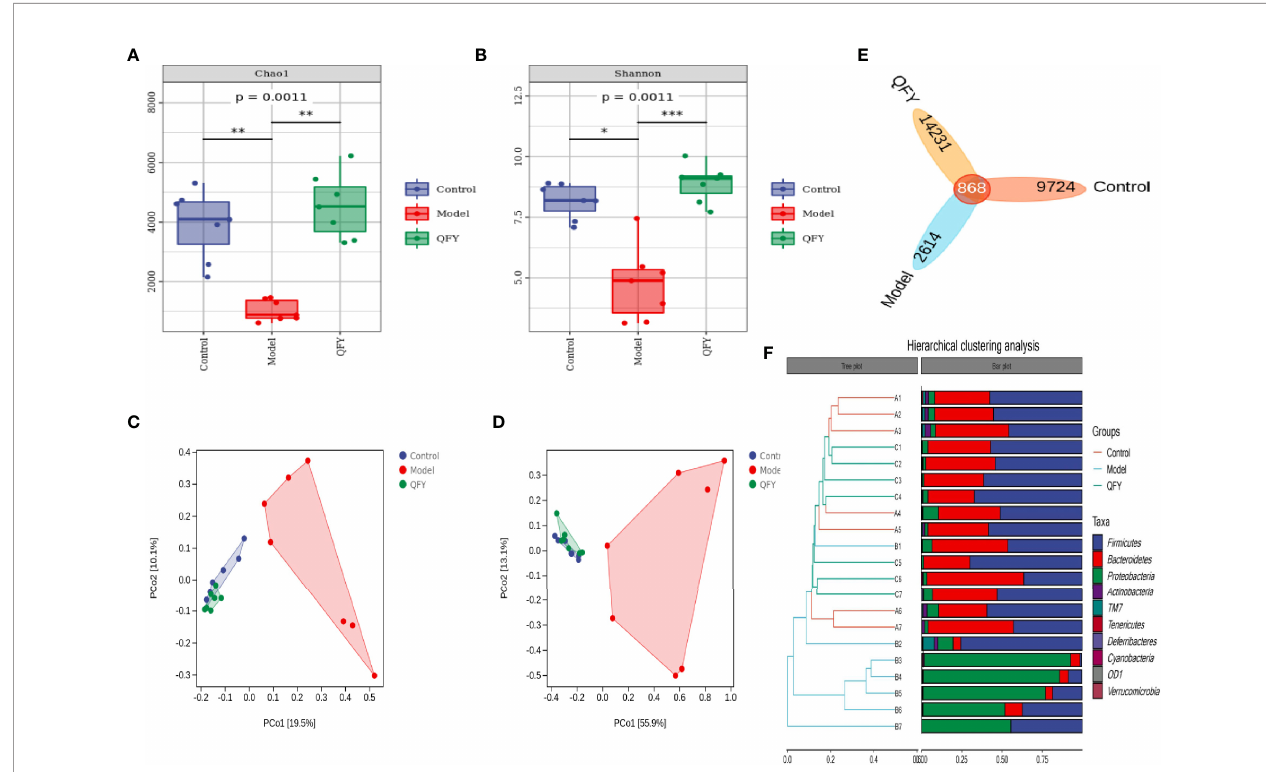
FIGURE 2 | Alpha diversity metrics comparisons among Control, Model, and QFY groups using (A) Chao 1 indices, (B) Shannon indices, and (C, D) weighted and unweighted UniFrac distance-based PCoA, respectively. (E, F) The Venn diagram illustrating overlaps of phylum-level OTUs and the hierarchical cluster analysis results for each group. Data are presented as the mean ± SD for each group ( n = 7), * p < 0.05, ** p < 0.01 versus Control; ** p < 0.01, *** p < 0.001 versus